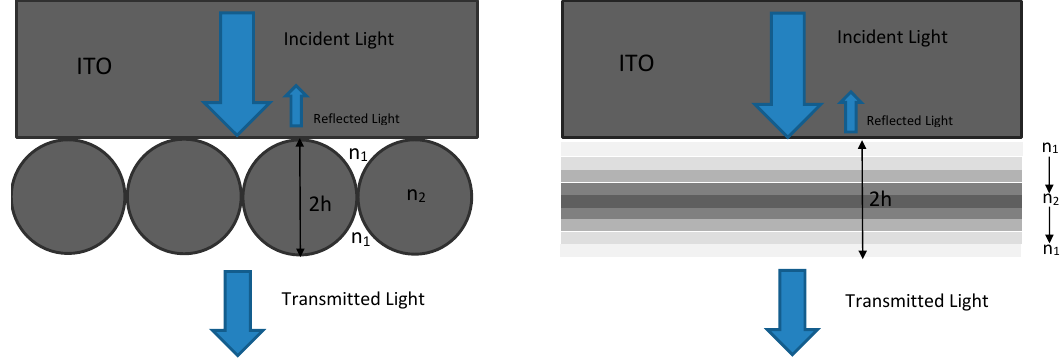
Figure 2. EMT representation of the nanospheres as a planar stack of changing refractive index.